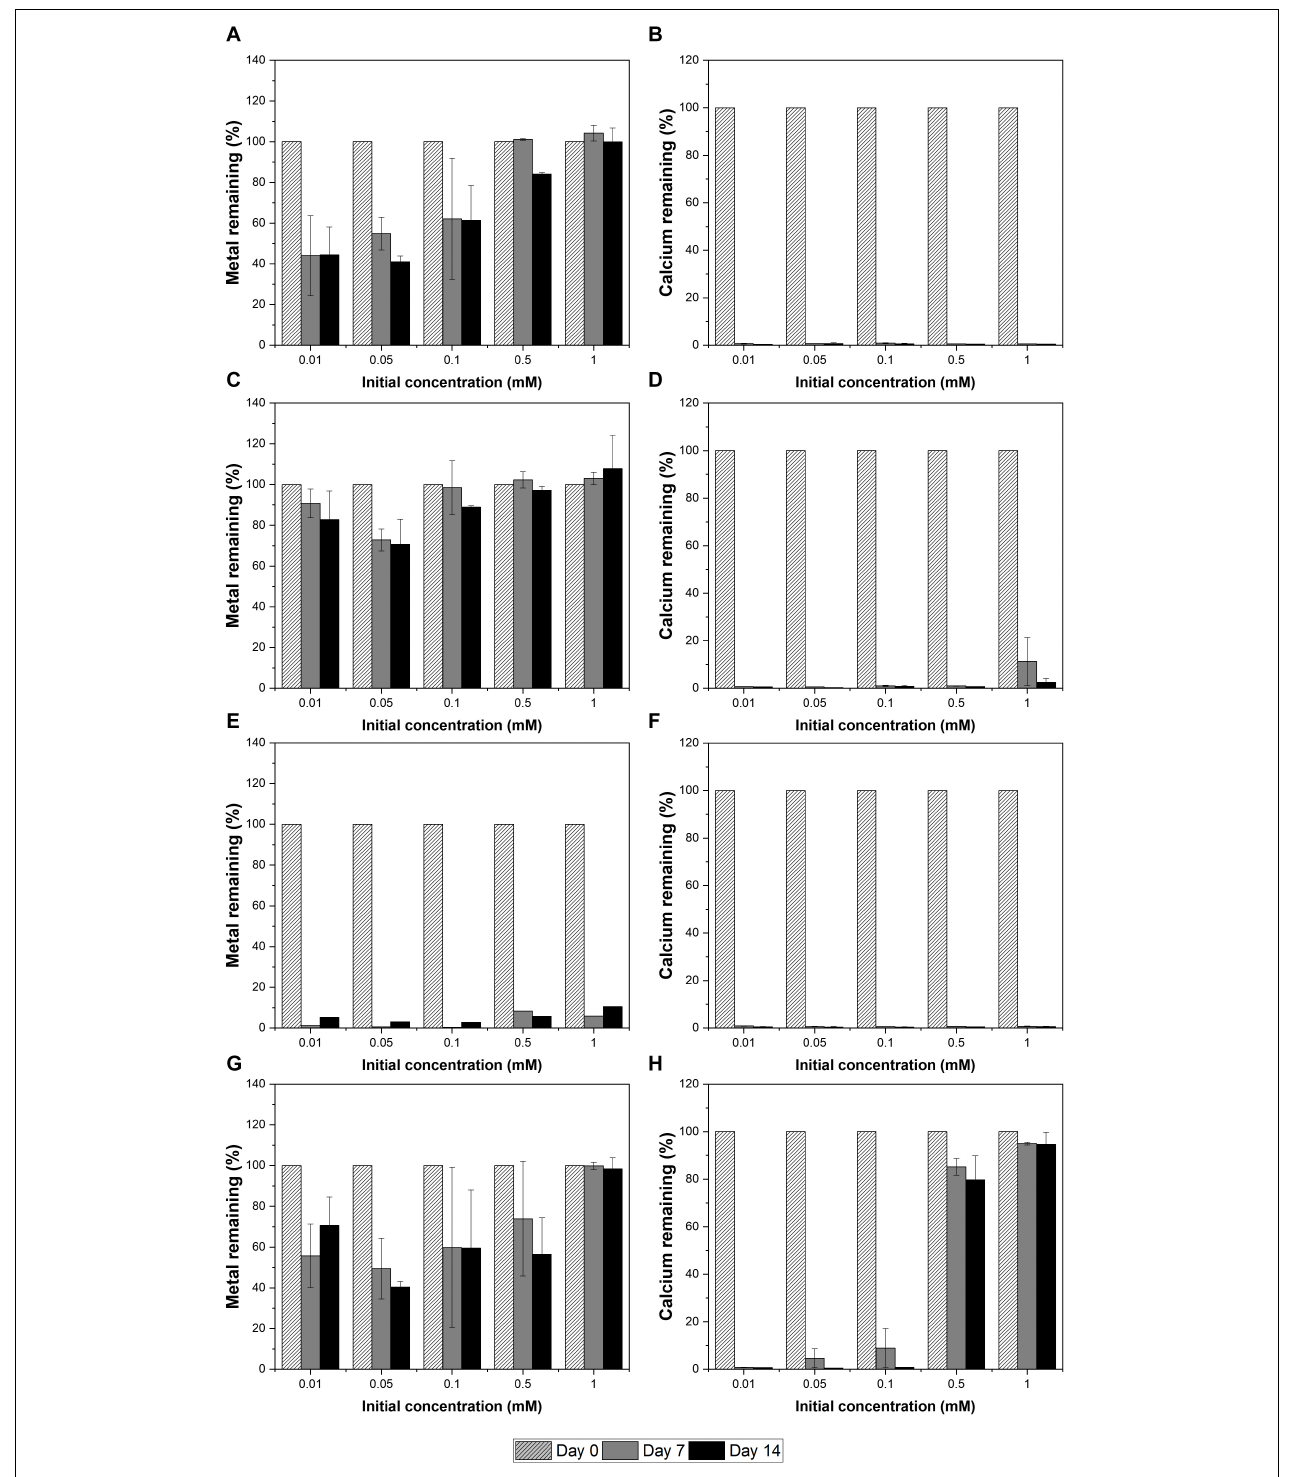
FIGURE 2 | Removal of metals and calcium at a range of metal concentrations by KCTC 3558 in urea growth medium for 2 weeks: Cu (A,B) ; Zn (C,D) ; Pb (E,F) ; and Cd (G,H) .